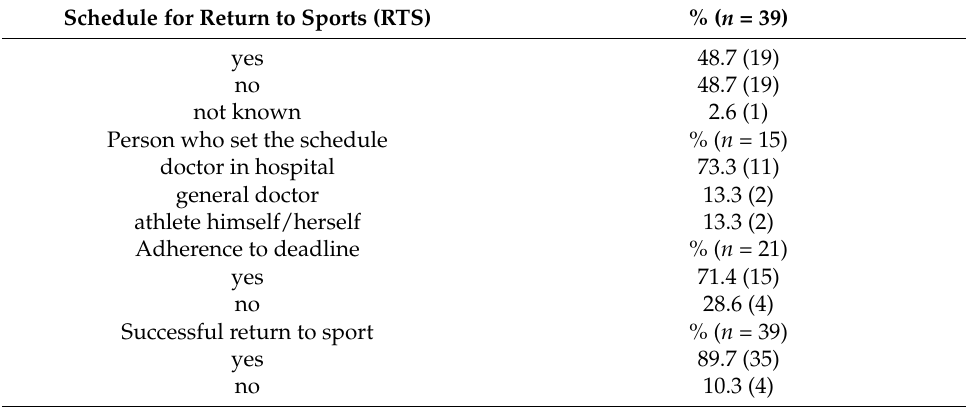
Table 3. Return to sports information of the athletes with a sports-related